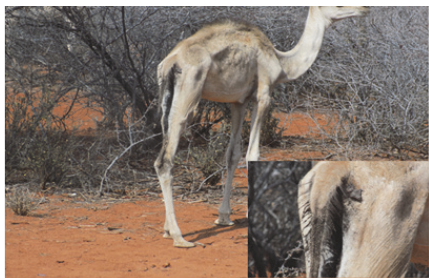
Figure 2: Suspected case of PPR of a male calf showing emaciation and diarrhea in Mandera.